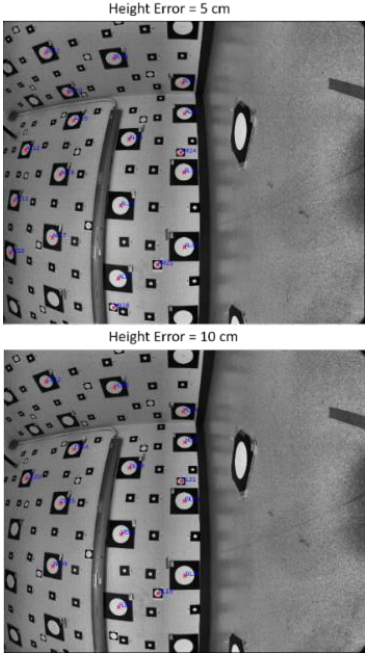
Figure 10. Height measurement error simulation for targets